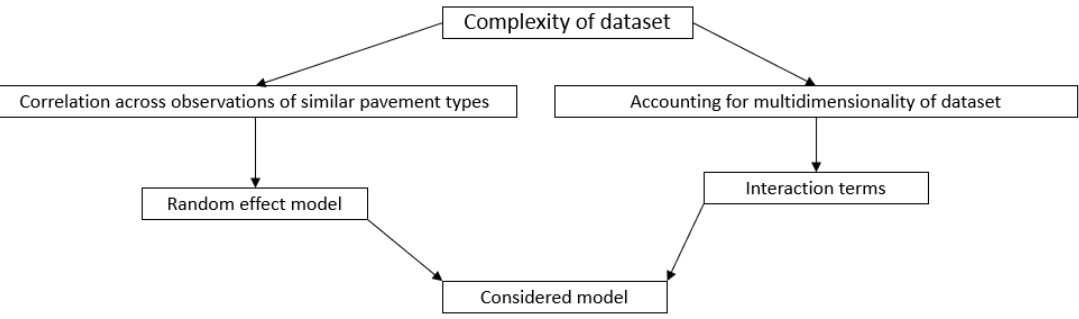
Figure 1. Methodological approach of this study to account for data heterogeneity.